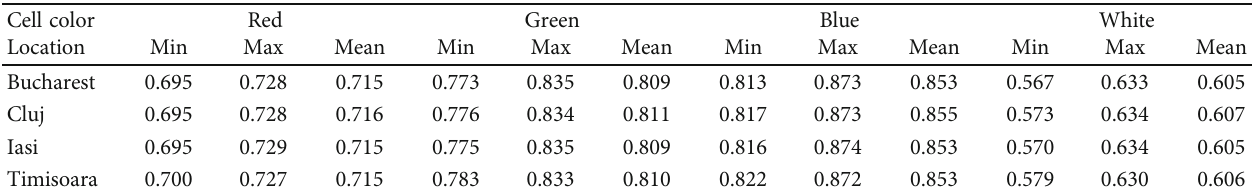
Table 1: Minimum, maximum, and mean values of spectral factor (Equation (1)) evaluated over 2012-2020 for the four colored solar cells considered in this study. The computation was done assuming the cells operating in the main four urban areas in Romania. Cell color